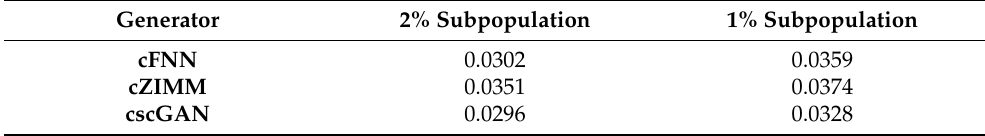
Table 2. cFNN, cZIMM and cscGAN MMD scores for the cases of 2% and 1% rare population (RBF kernel, σ = 500). Notice that the value of σ is now two orders of magnitude larger than it was in Table 3 because the data account for gene counts (i.e., unnormalized). The baseline MMD score calculated over the test set and 50 randomly chosen equally-sized training sets is equal to & 0.0086 ± 0.002. Lower MMD value is preferable.